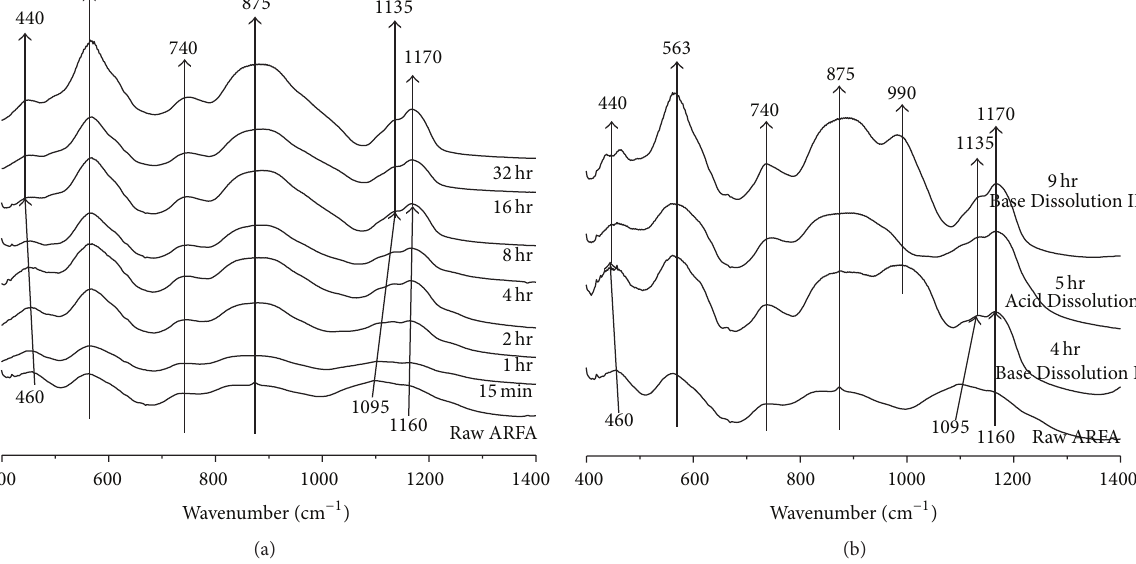
Figure 6: The FTIR spectra of ARFA from acid (a) and base (b) digestion processes. Note that the spectra in (a) and (b) have been offset for